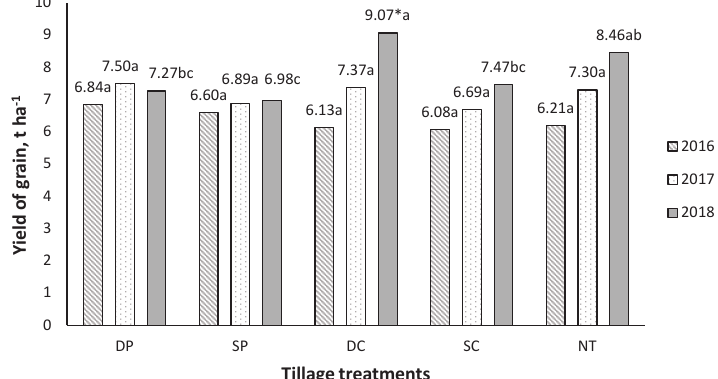
Fig. 4. Effects of different tillage practice on faba bean grain yield (t ha -1 ). * = significant differences from the control treatment (DP) at p ≤ 0.05; ** = at p